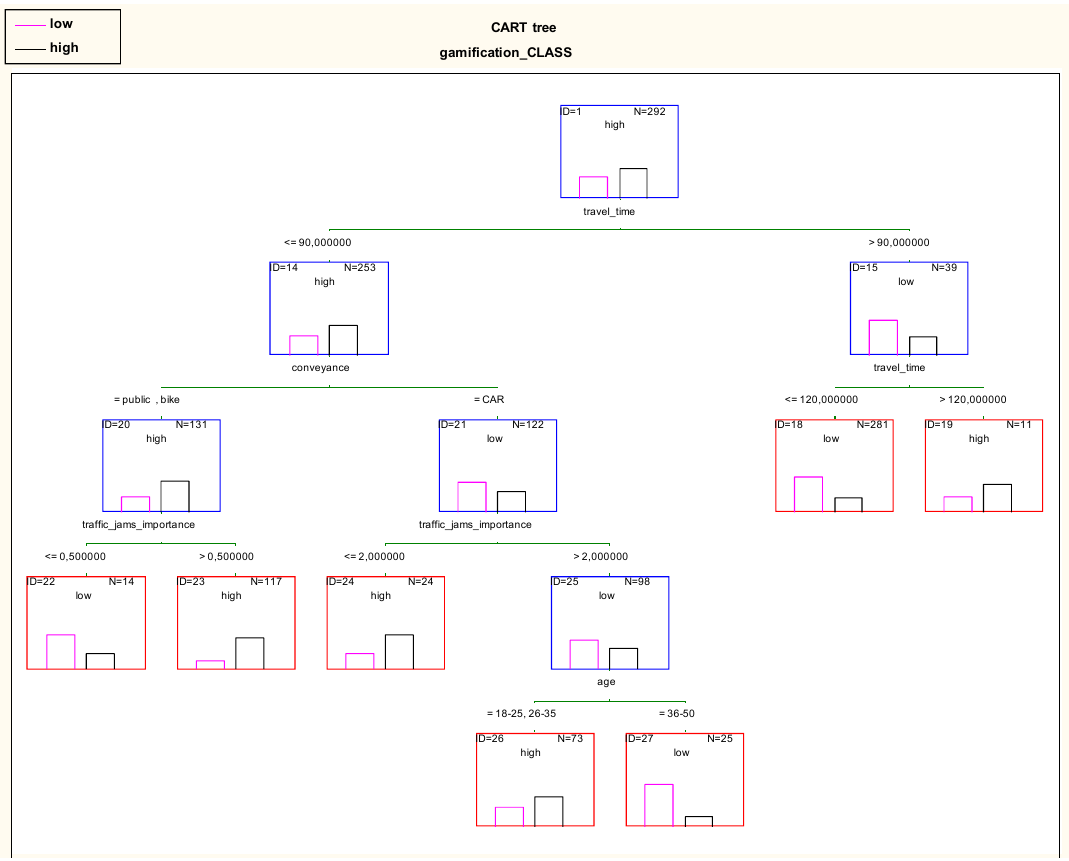
Figure 4. Classification and regression tree (CART) explaining the level of interest in carpooling and gamification.